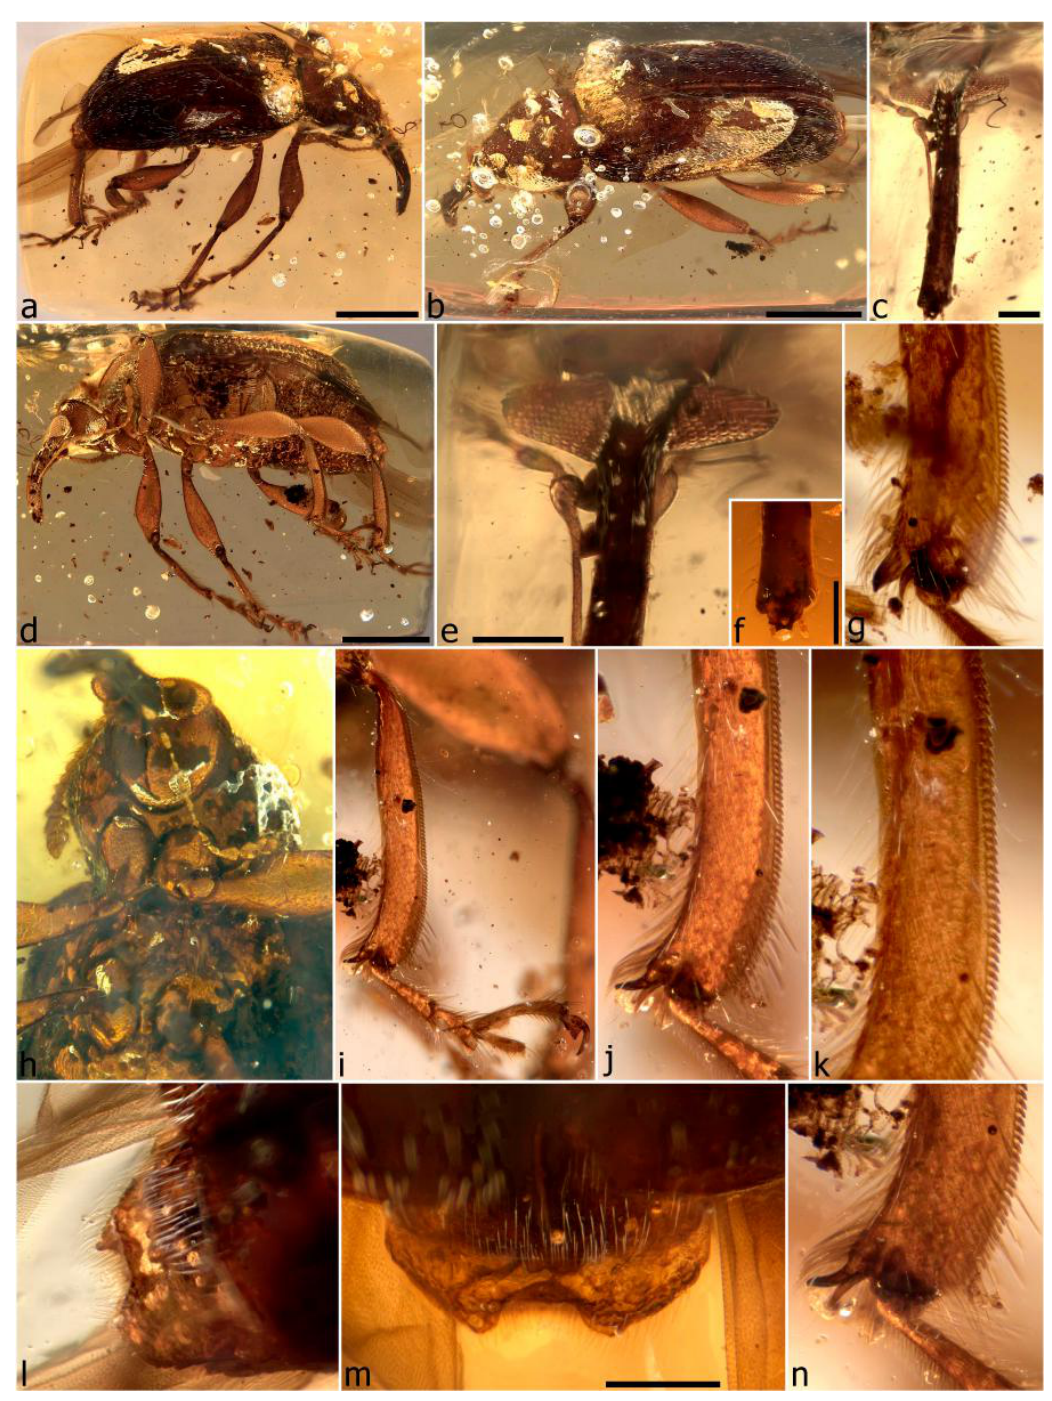
Figure 91. Elwoodius conicops sp. n., holotype. Habitus, right lateral ( a ); habitus, dorsal oblique ( b ); head and rostrum ( c ); habitus, left lateral ( d ); head ( e ); apex of rostrum and mandibles, dorsal ( f ); left metatibia ( g ); head and thorax, ventral ( h ); mesotibiae and tarsus ( i ); mesotibiae showing spurs ( j ); mesotibiae, detail of dorsal pectination ( k ); tergite VII, dorsal oblique ( l ); tergite VII, dorsal ( m ); mesotibial spurs ( n ). Scale bars: 1.0 mm (a,b,d); 0.2 mm (c,e,f,m).